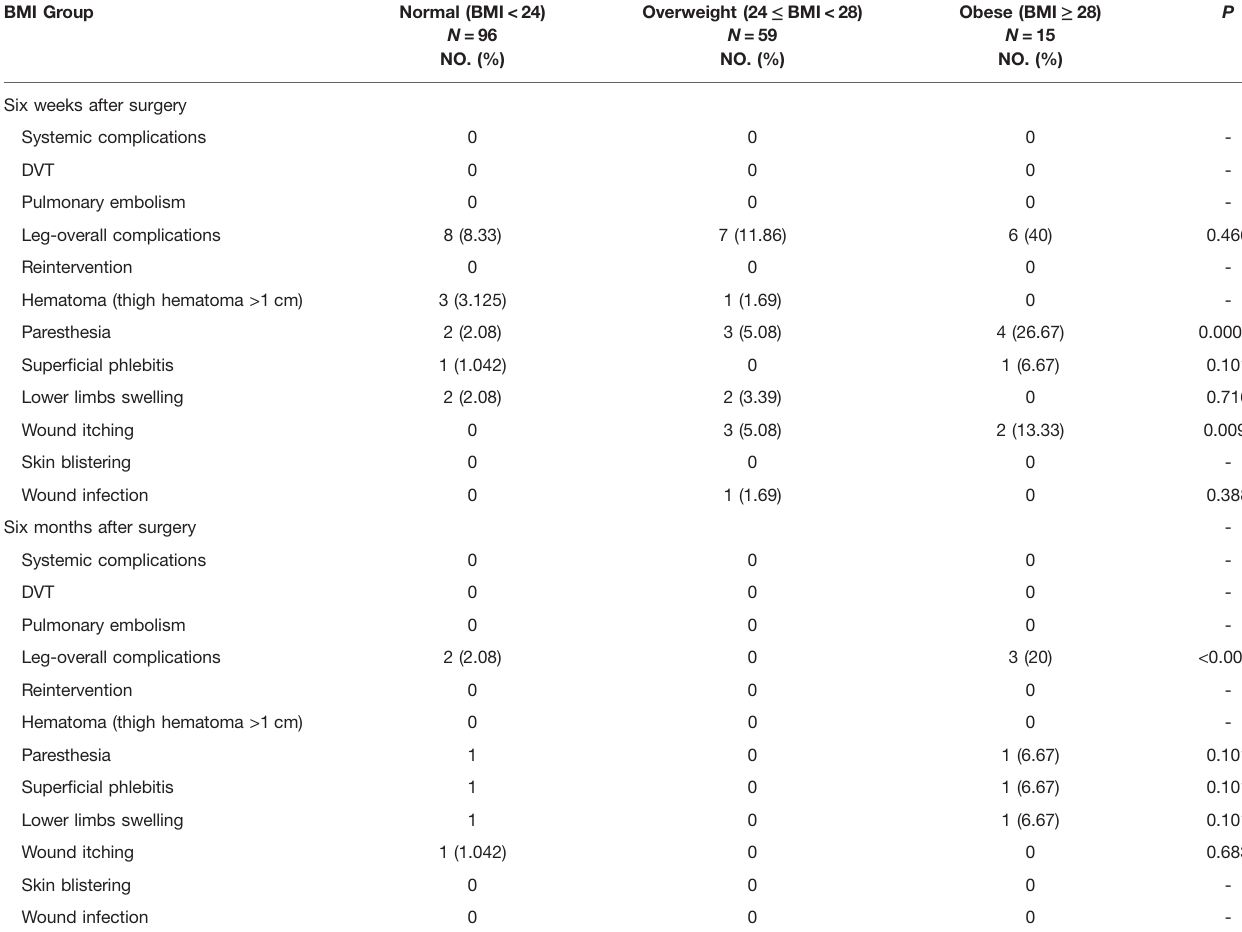
TABLE 5 | Complications after HLS in an ambulatory care at six weeks and six months after